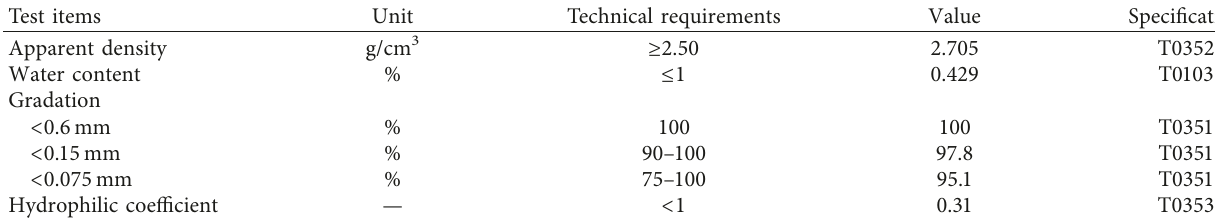
Table 2: Technical properties of LMF.